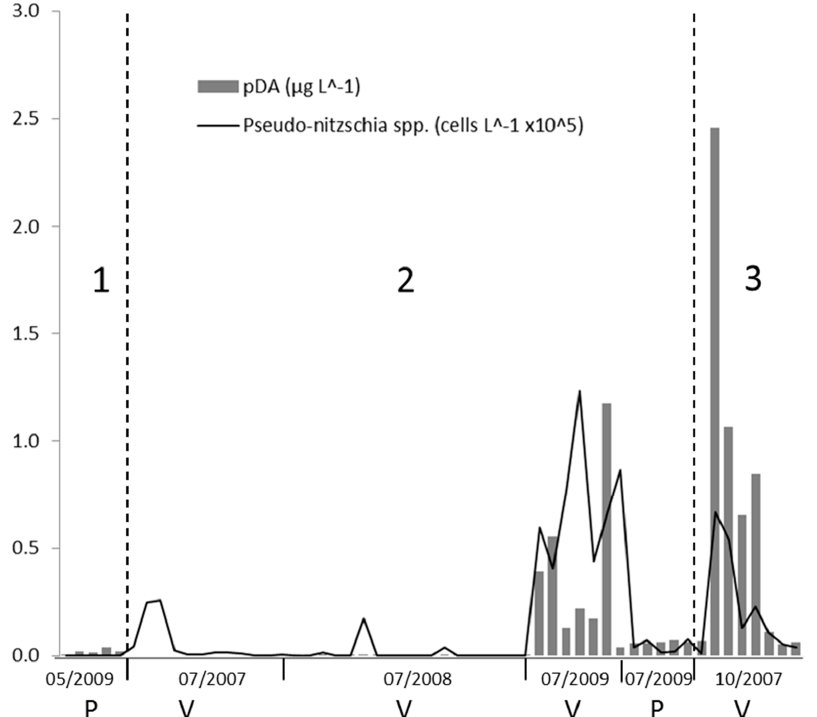
Figure 4. Abundance of Pseudo-nitzshi a spp. plotted with concentration of pDA across all the stations in Ria de Vigo ( V ) and Ria de Pontevedra ( P ) during our sampling period for periods ( 1 ) (spring downwelling), ( 2 ) (summer), and ( 3 ) (autumn downwelling).